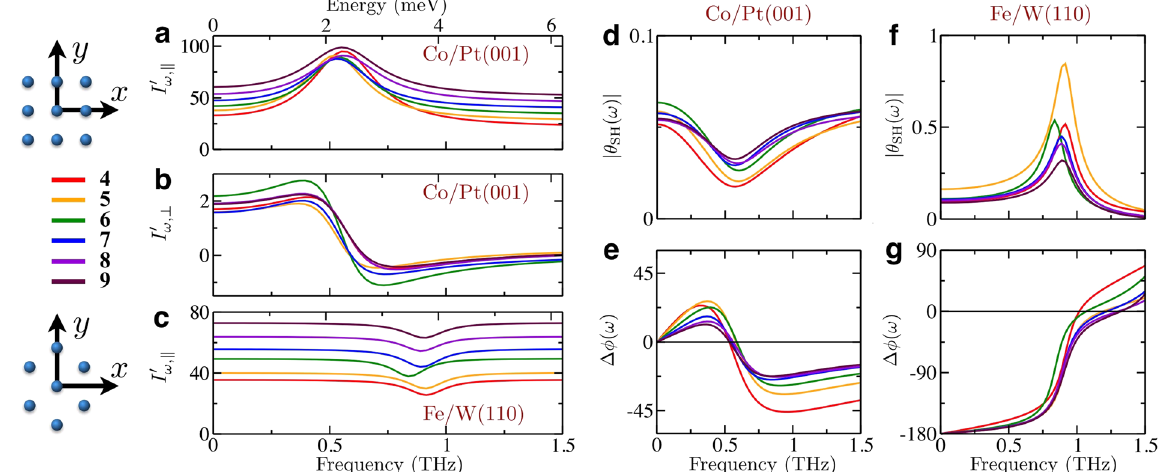
Figure 2. Dependence of the longitudinal and transverse charge currents and of the dynamical spin Hall angle on the frequency of the applied electric field. All calculations were performed for zero external magnetic field. ( a ) Longitudinal and ( b ) transverse in-phase currents calculated for monolayers of Co/Pt(001) as functions of the frequency, for different thicknesses of Pt. The magnetization is normal to the surface due to the easy axis anisotropy of the system. ( c ) Longitudinal in-phase currents calculated for monolayers of Fe/W(110) as functions of the frequency, for different W thicknesses. The magnetization lies in-plane in this case, again due to the magnetic anisotropy. As the electric field is parallel to the magnetization, ′ = ω ⊥ I 0 (not shown). ( d–g ) , Amplitude and phase of the complex spin Hall angle, θ θ = ϕ ∆ e i , for Co/Pt(001) and Fe/W(110). The dc SH SH spin Hall angle is positive for Co/Pt(001) and negative for Fe/W(110), as seen from the phases. On the left side we indicate the substrate thickness, measured in atomic planes, and the position of the atoms on every layer with respect to our choice of axes for Co/Pt(001) (top) and Fe/W(110)